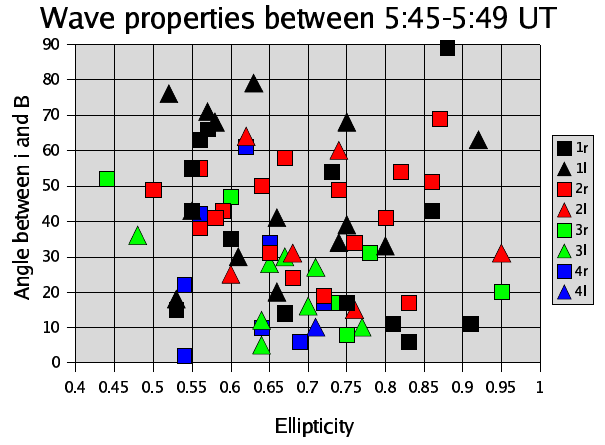
Fig. 14. Wave properties between 05:45–05:49 UT. Squares and tri- angles represent right-hand and left-hand polarized waves, respec- tively. The format is the same as Fig.